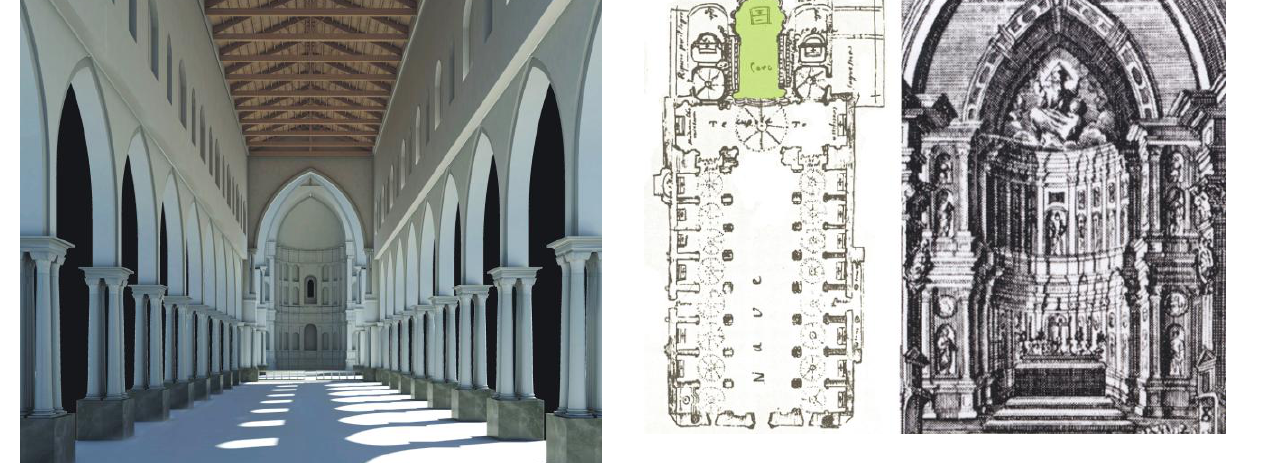
Figure 4: The Tribuna of Gagini.